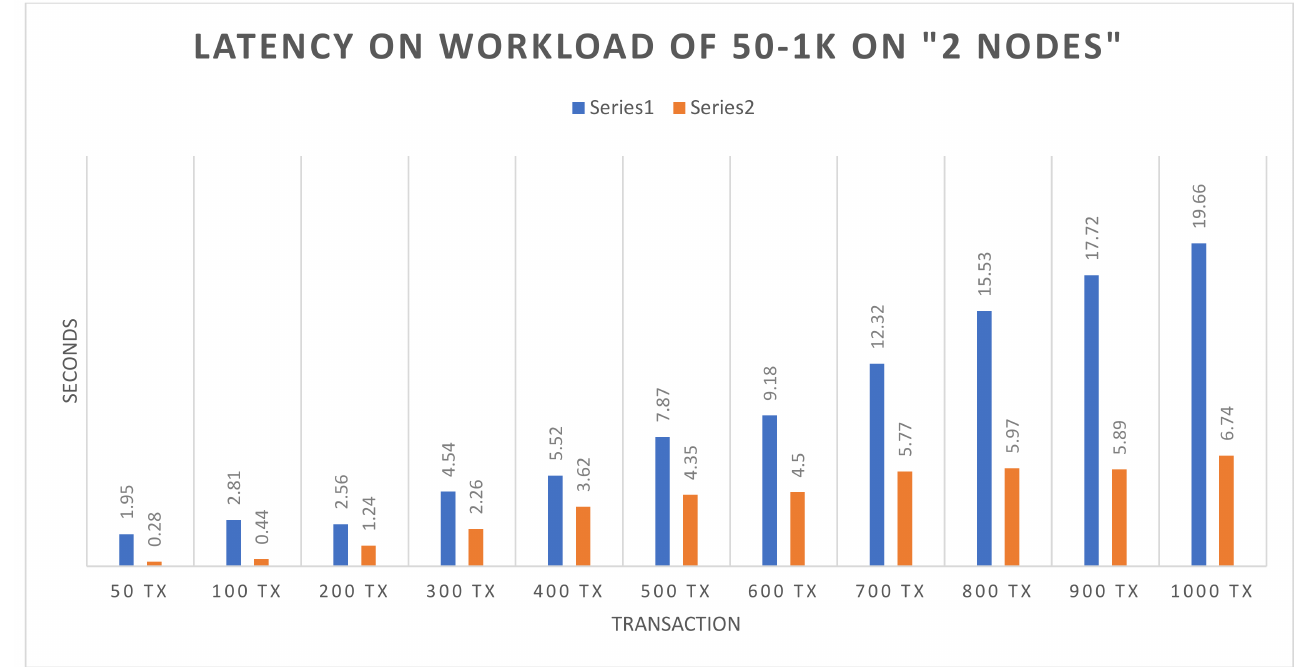
Figure 5. Average latency on the open and the query